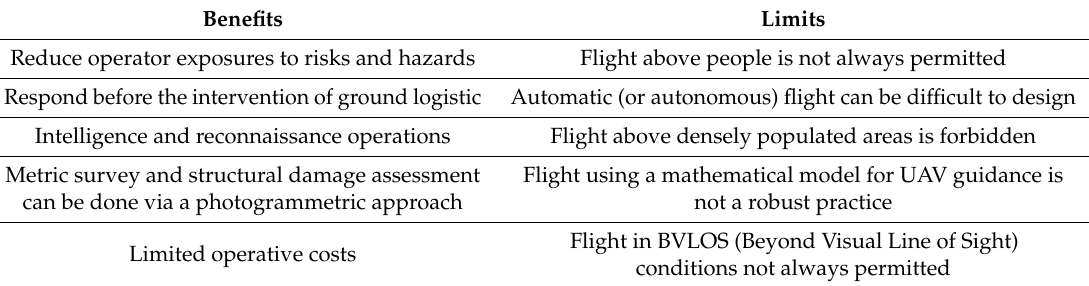
Table 7. Summary of the benefits and limits of the use of UAVs for the discussed contexts.